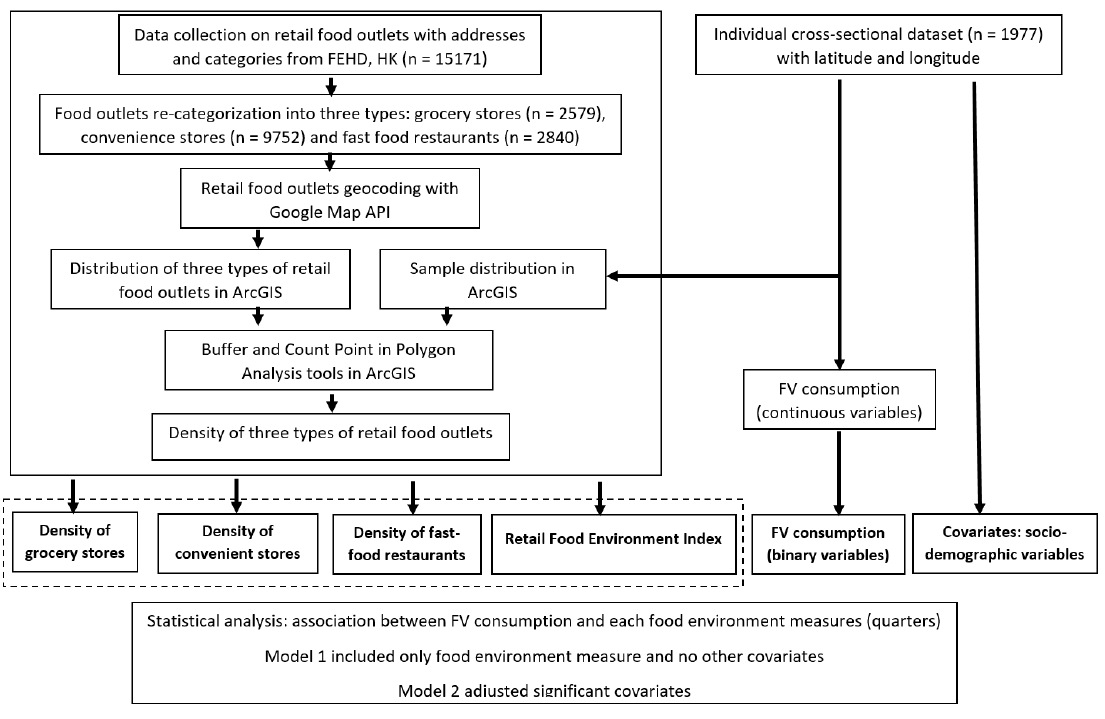
Figure 1. Research workflow.